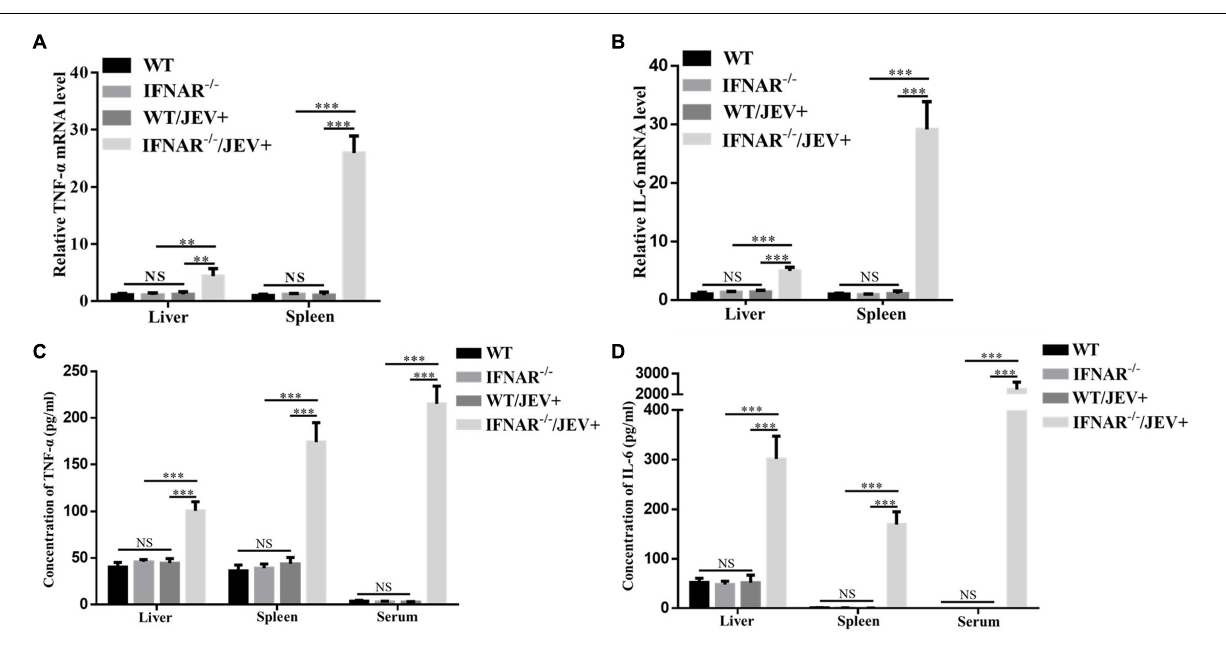
FIGURE 5 | The expression level of inflammatory cytokines TNF- α and IL-6 significantly increased in IFNAR − / − mice infected with SA14-14-2. (A,B) WT and IFNAR − / − mice were intraperitoneally infected with JEV SA14-14-2 at 4 dpi, followed by real-time PCR for the mRNA levels of TNF- α and IL-6 in liver and spleen. (C,D) Corresponding protein levels TNF- α and IL-6 in liver and spleen and serum were measured by ELISA. All the data represent mean ± SD of biological triplicates from at least three independent experiments. The Student’s t -test performed statistical analyses. ∗∗ P < 0.01, ∗∗∗ P < 0.001, NS, no